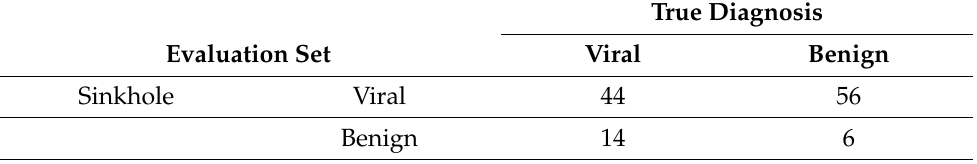
Table 18. C-SVM model: Sink-middle. True Diagnosis Evaluation Set Viral Benign Viral 100 0 Benign 5 15